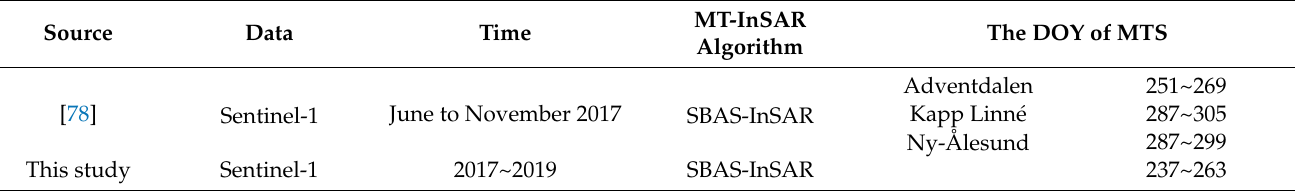
Table 6. Comparison of the DOY subsidence maxima of AL between QTP and Circum-Arctic region. Source Data Time